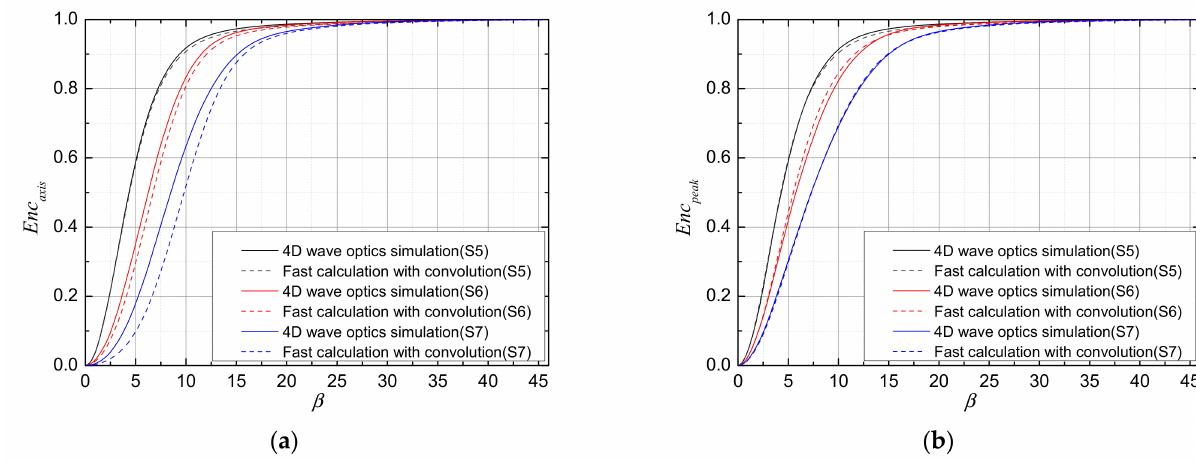
Figure 10. The change curve comparison between the fast calculation results and 4D wave optics simulation results of ( a ) Enc axis and ( b ) Enc peak with facula expansion multiple β under S5, S6, and S7 scenarios.